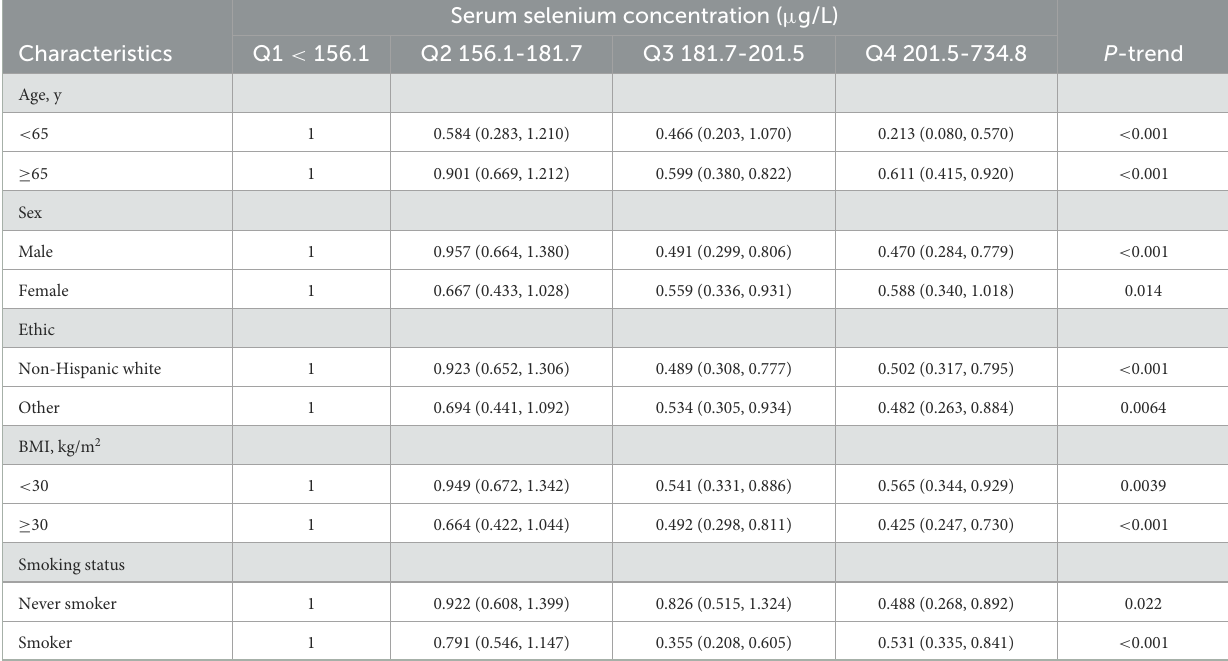
TABLE 5 Subgroup analyses of the associations between serum selenium concentrations and CVD mortality among CKD patients a . Serum selenium concentration ( µ